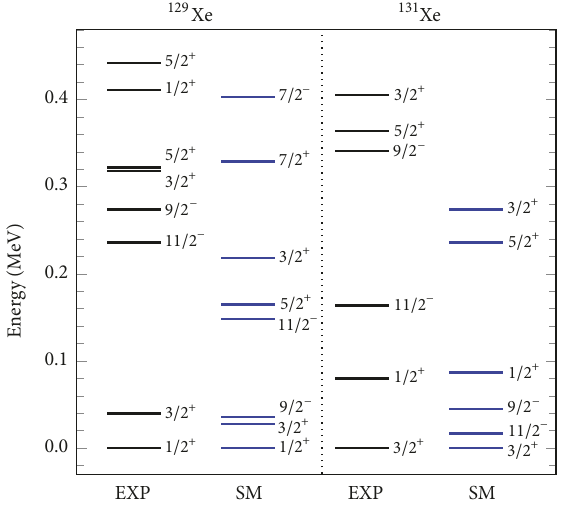
Figure 3: Experimental and shell-model energy spectra of odd- mass xenon isotopes 129 Xe (left) and 131 Xe